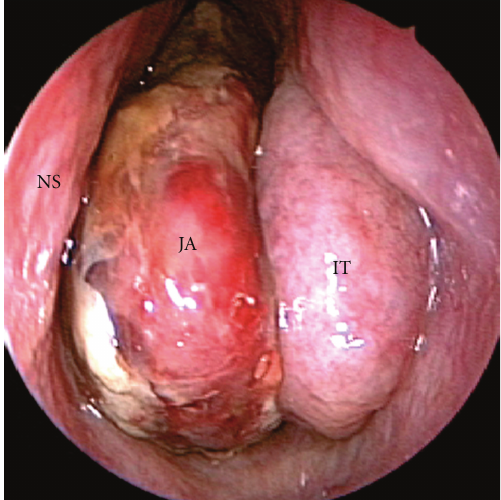
Figure 4: Endoscopic appearance of JA showing a lobulated hypervascularized mass with a smooth surface partially covered by fibrin growing into the left nasal fossa. NS: nasal septum; IT: inferior turbinate; JA: juvenile